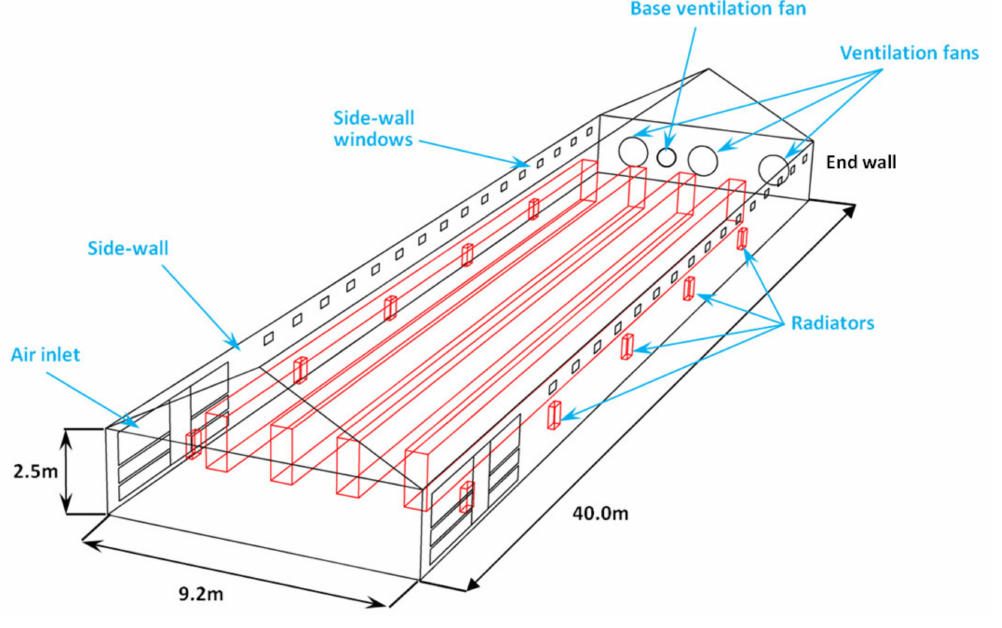
Figure 1. Schematic drawing of the modeled poultry house. Table 1. The thermal-physical parameters of the main elements of the poultry